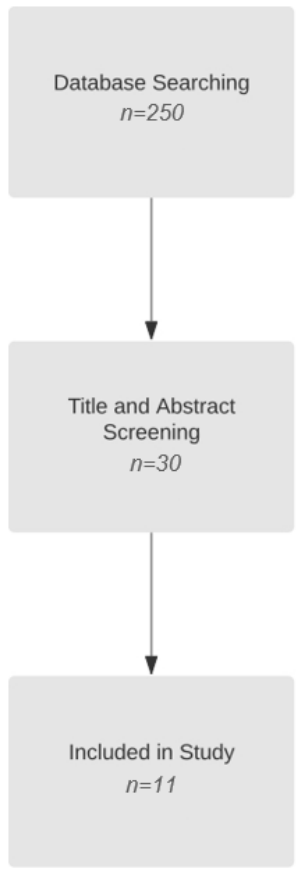
Figure 1. Studies used in NLR.